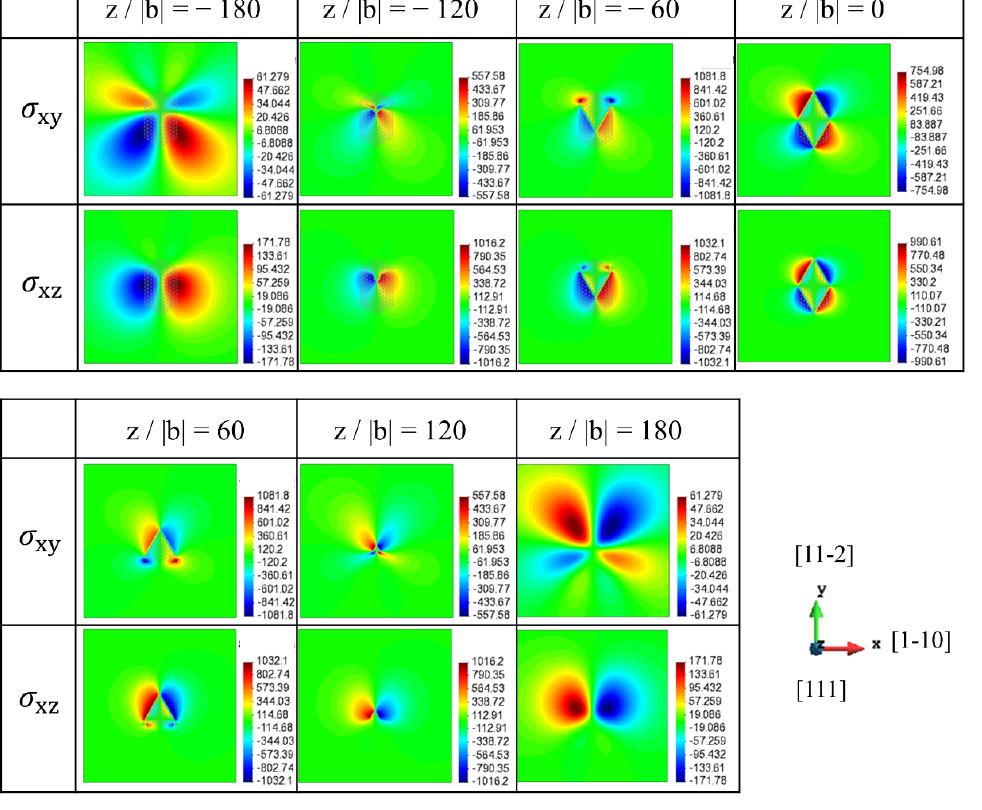
and in disloca- 𝜎𝜎 xy 𝜎𝜎 xz